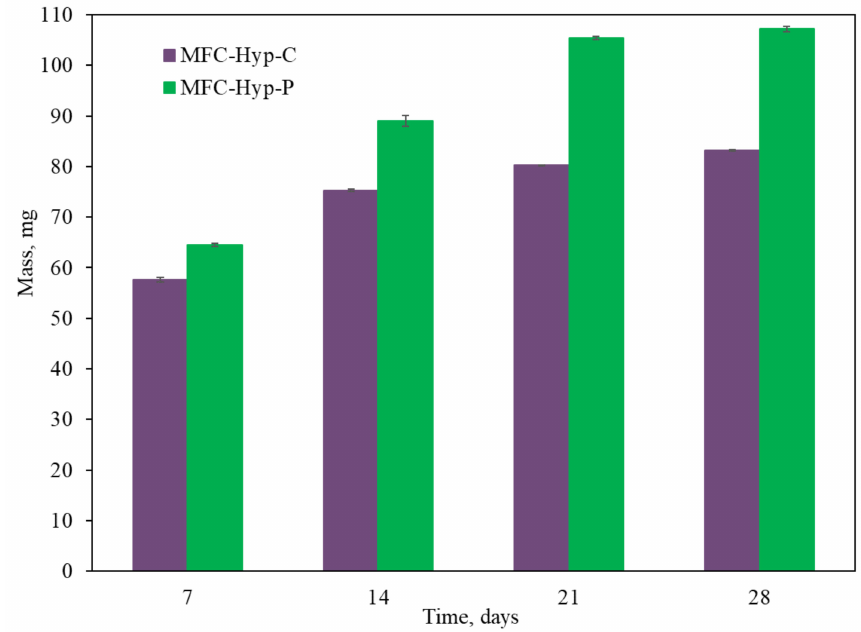
Figure 7. Temporal changes in the mass of phosphate in water in the control (MFC-Hyp-C) and the Hyp with the plant A. tuberosum